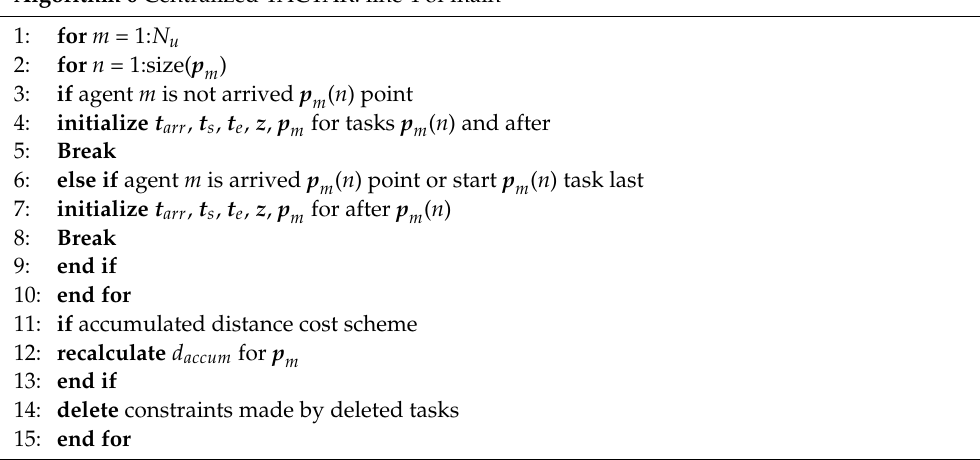
Algorithm 6 Centralized TACTAR: line 4 of